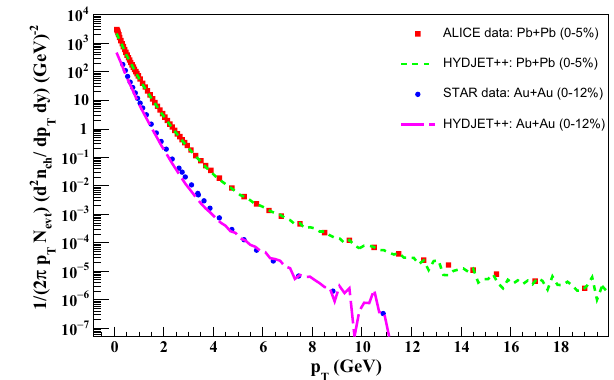
Fig. 13 Comparision of pseudorapidity distribution of HYDJET++ and AMPT model results in tip–tip and body–body configuration for most central collisions. AMPT results are taken from Ref. [38]